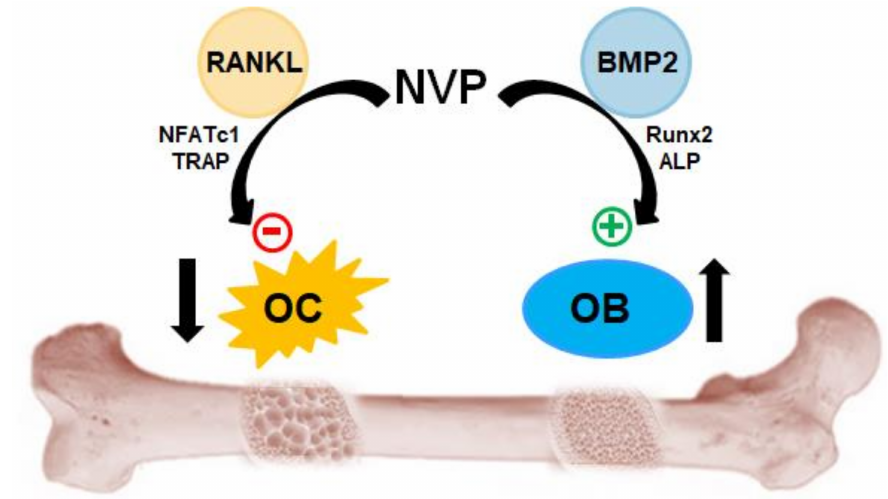
Figure 8. Role of NVP in bone homeostasis. NVP has a dual function in the inhibition of RANKL- induced osteoclastogenesis and the stimulation of BMP2-induced